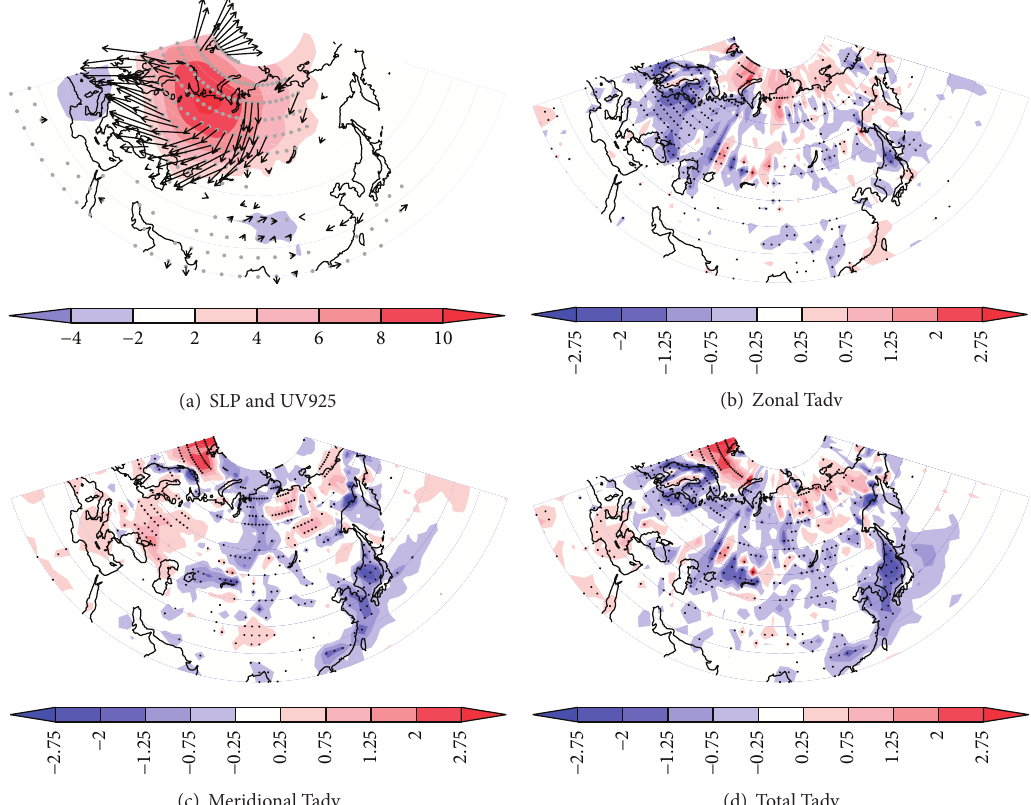
Figure 6: Composite difference between high and low ECI years ( ± 0.5 SD) from 1979 to 2013 for the SLP (shaded) and 925 hPa wind field (vector) in ((a) the units are hPa for SLP, m ⋅ s −1 for 925 hPa wind) the zonal temperature advection ((b) unit: K ∗ day −1 ), the meridional temperature advection ((c) unit: K ∗ day −1 ), and the total horizontal temperature advection ((d) unit: K ∗ day −1 ). The dotted areas and wind vectors indicate a significant difference that exceeds 0.05 for the two-tailed Student’s 𝑡 -test.